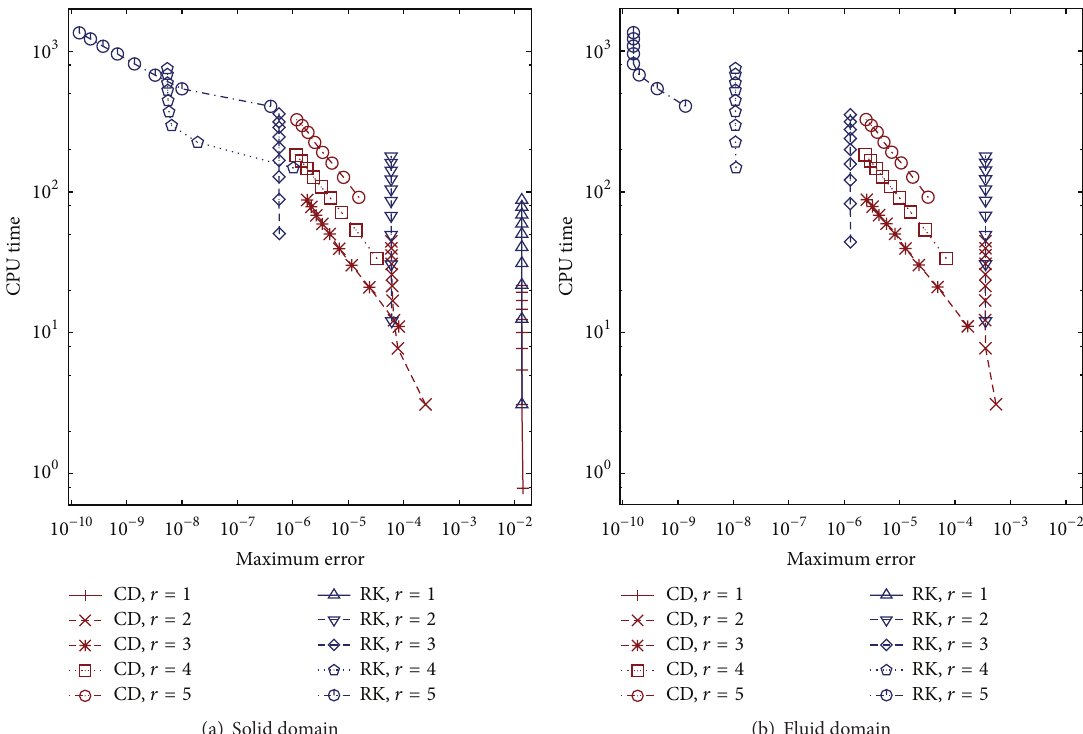
Figure 5: Accuracy with respect to CPU time consumptions (in seconds) with the CD and the RK time discretizations. The mesh step size is fixed to be ℎ = 1/20 , and the time step refinement gives a series of numerical results with various lengths of the time step for each element